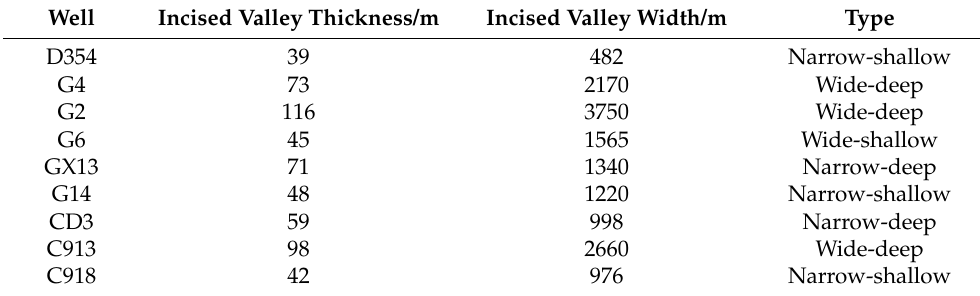
Table 5. Statistical table of incised valley characteristics in the Guojuzi